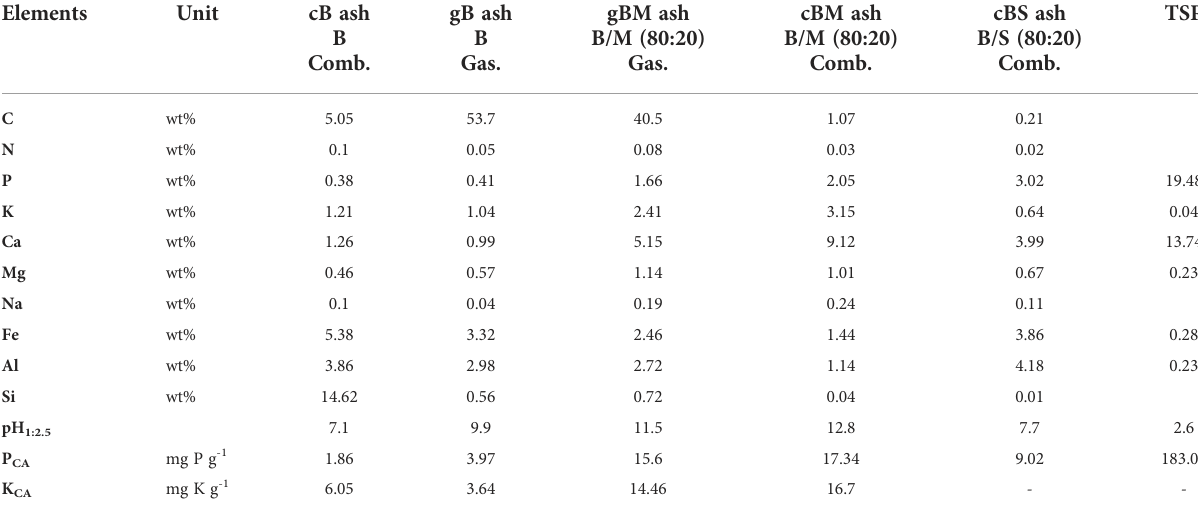
TABLE 1 Chemical compositions of cB, gB, gBM, cBM and cBS ashes and triple superphosphate (TSP). Elements